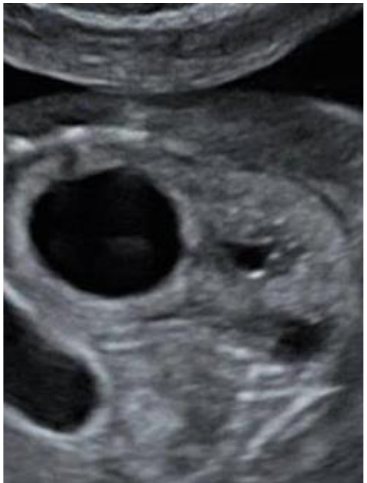
Figure 5. Hydronephrotic upper pole of the left kidney.